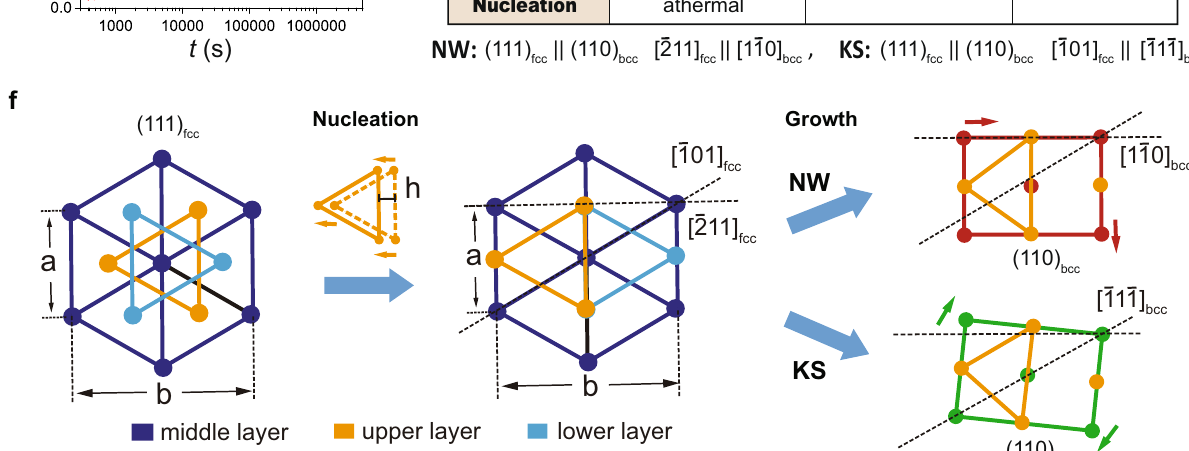
concentration (fcc-stable, i.e. C AOT = 70 mM) to a low concentration (bcc-stable, i.e. C AOT = 10 mM) provides the system with a driving force Δ μ of the fcc-to-bcc transition. At the same time, reducing